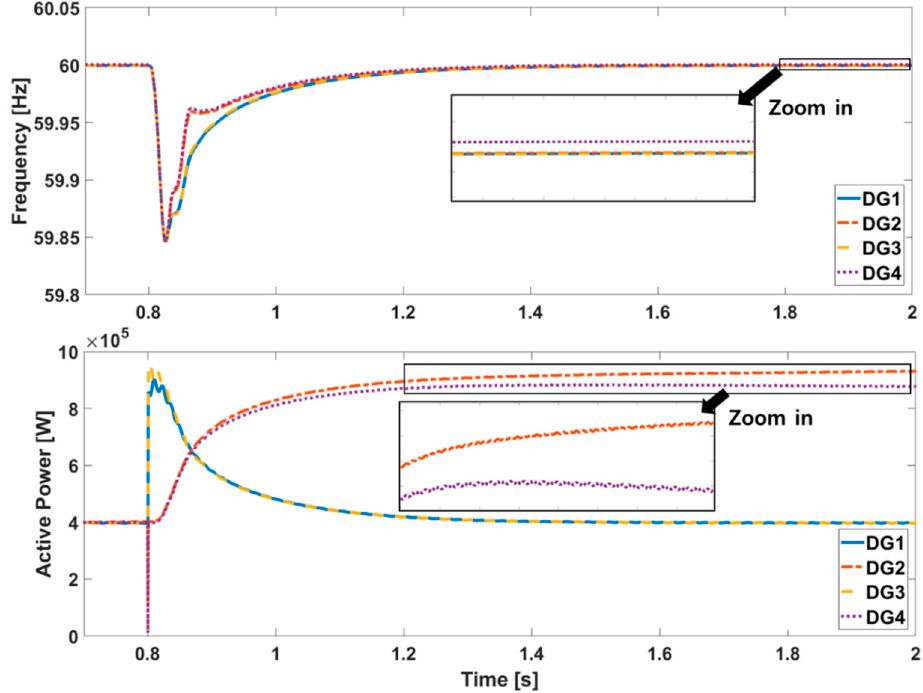
Figure 5. Frequency restoration results achieved using the integral controller.